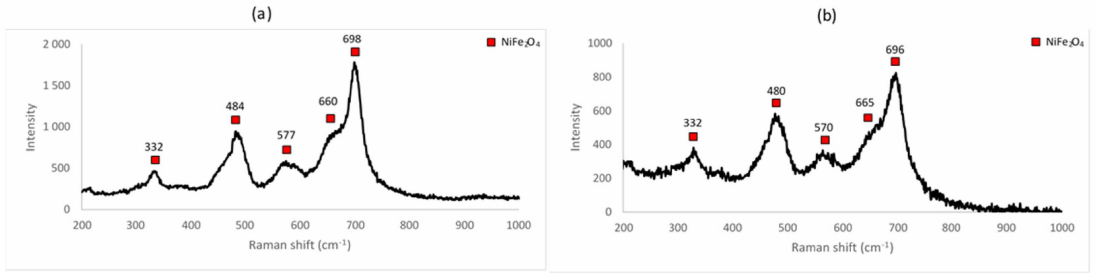
Figure 9. Raman spectrum for ( a ) sample A_4 (1000 ◦ C for 72 h) and ( b ) A_5 (1000 ◦ C for 96